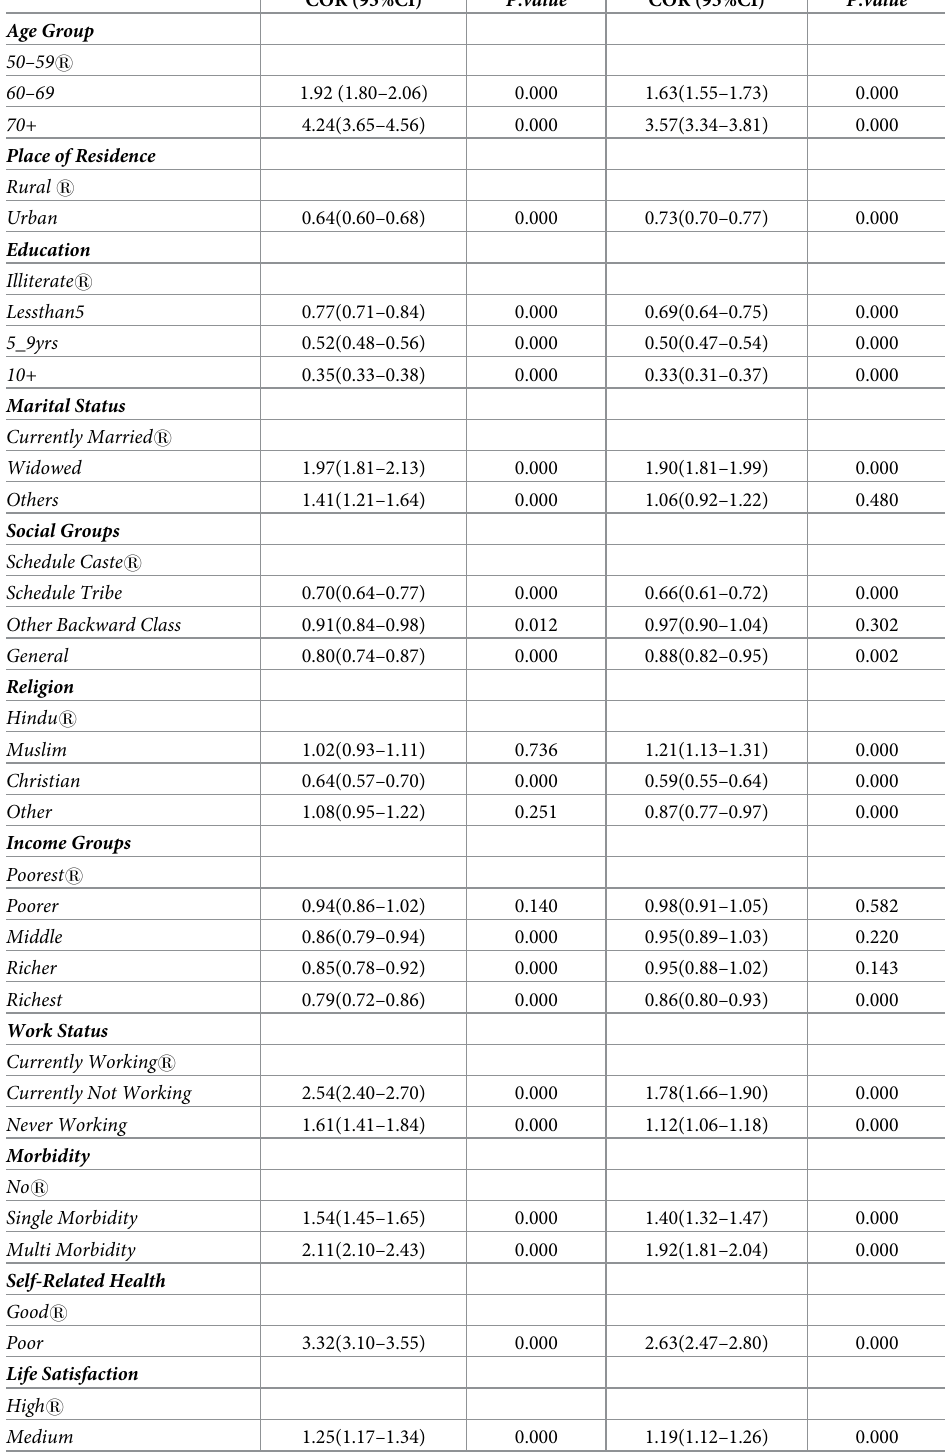
Table 2. Association between socio-demographic and health factors with functional disability using crude odds ratio by gender among older adults aged 50 and above in